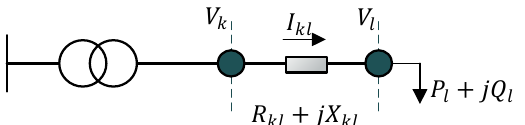
Algorithm 1. Identification of nominee locations for DG integration